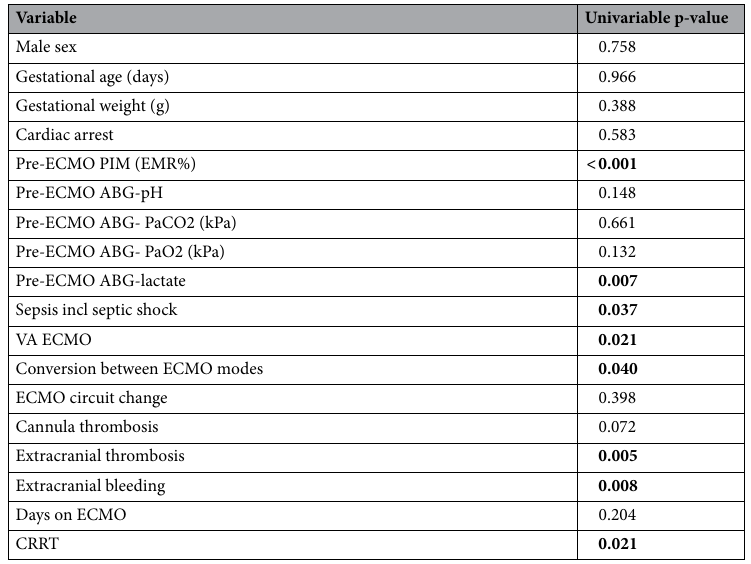
Table 2. Univariable logistic regression of possible predictors for brain infarction diagnosis during ECMO treatment. Bold text highlights significant statistically significant parameters (p-value < 0.05). ABG = arterial blood gas, CI = confidence interval, CDH = congenital diaphragmatic hernia, CRRT = continuous renal replacement therapy, ECMO = extracorporeal membrane oxygenation, ECPR = extracorporeal cardiopulmonary resuscitation, EMR% = estimated mortality rate in percent, MAS = meconium aspiration syndrome, PIM = pediatric index of mortality, PPHN = persistent pulmonary hypertension in the newborn, VA = venoarterial.